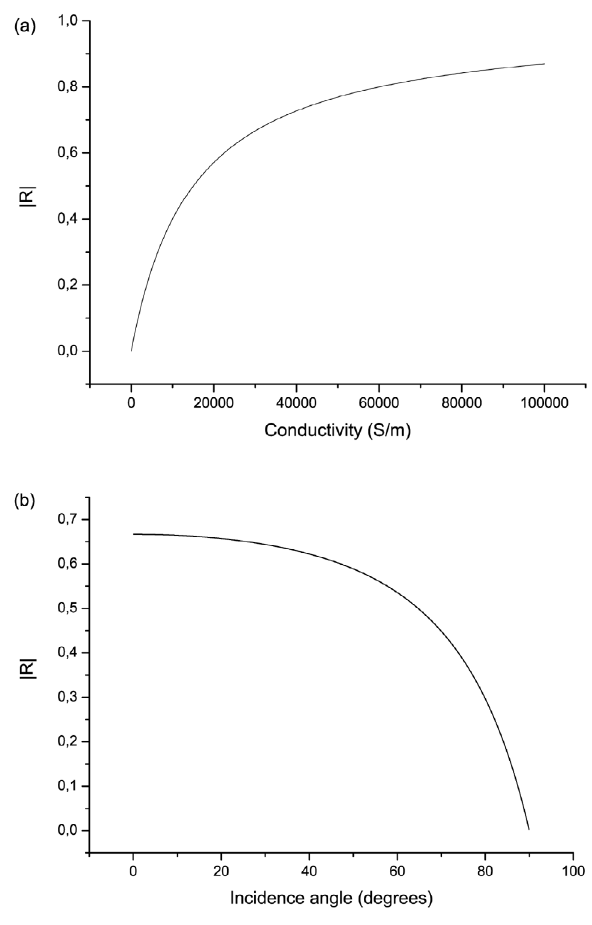
Figure 3. Absolute value of the reflection coefficient of the elec- tromagnetic wave as a function of conductivity (a) (normal inci- dence) and incidence angle (b) (for v ' = 30000 S/m). The frequency = 60 Hz 0 = 1 MHz and the layer thickness is h = 1 n is f 0